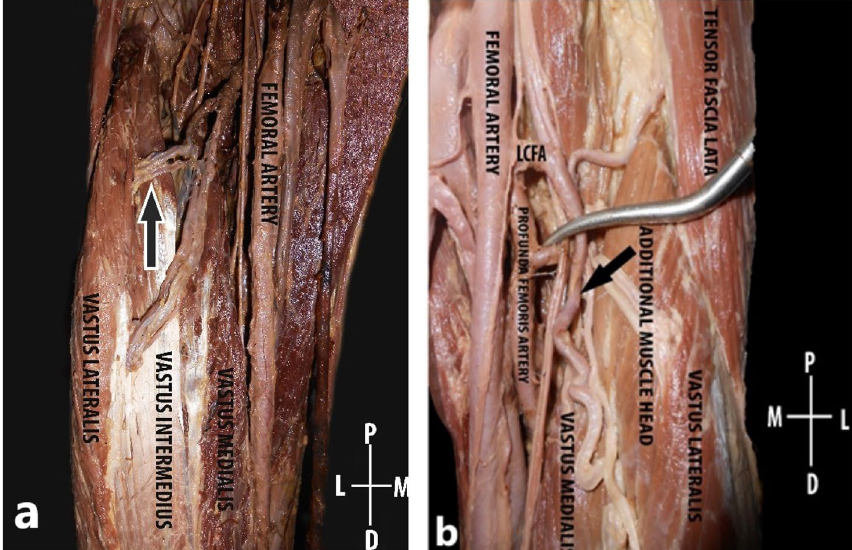
Figure 5. Anterior aspect of proximal third of thigh. The rectus femoris muscle has been reflected. The arrow shows the additional muscle head getting its blood supply from the transverse branch of LCFA ( a ). Arrow indicating the direct branch of profunda femoris artery and the descending branch of LCFA was having a highly tortuous course ( b ).